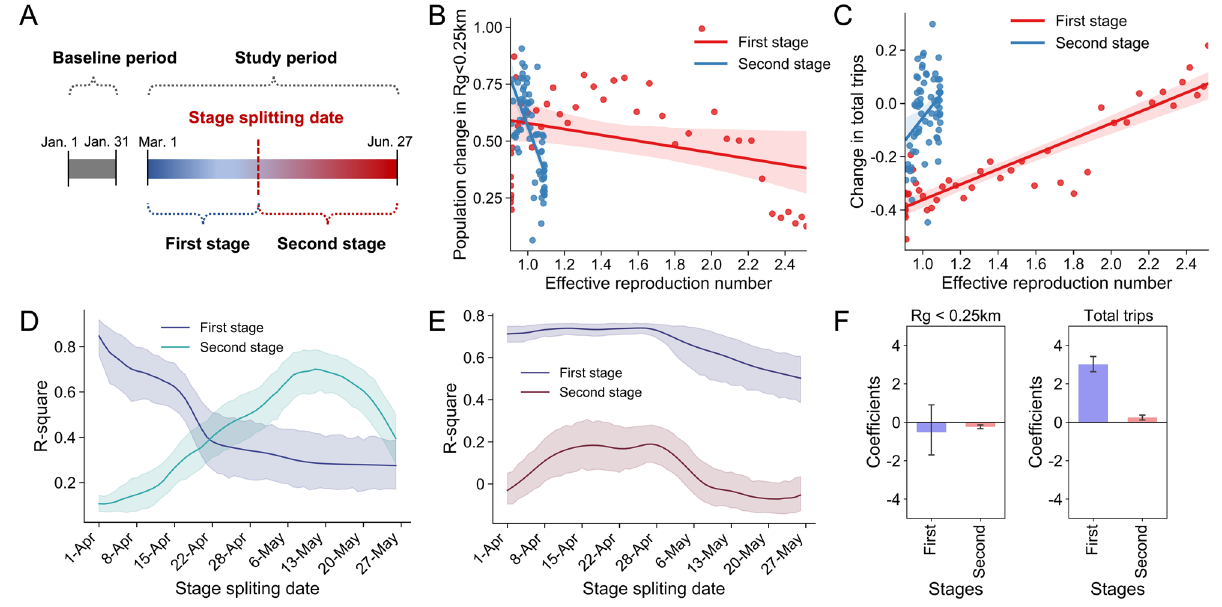
Figure 2. Results of stage splitting and dynamic relationships between mobility change and pandemic spread. ( A ) An illustration of stage splitting. ( B ) Example (Oakland County) of relationship change between effective reproduction number and population in smallest r g . The stage splitting date is April 20, 2020. ( C ) Example of relationship change between R t and number of trips. ( D ) The R 2 for the OLS regression between the number of people in the category of the smallest radius of gyration and R t in two stages based on stage-splitting dates in April and May. ( E ) The R 2 for the regression between the number of total trips and R t in two stages based on stage-splitting dates in April and May. ( F ) The coefficients β 1, i values in two different stages for two metrics. The splitting date in this example is April 20,